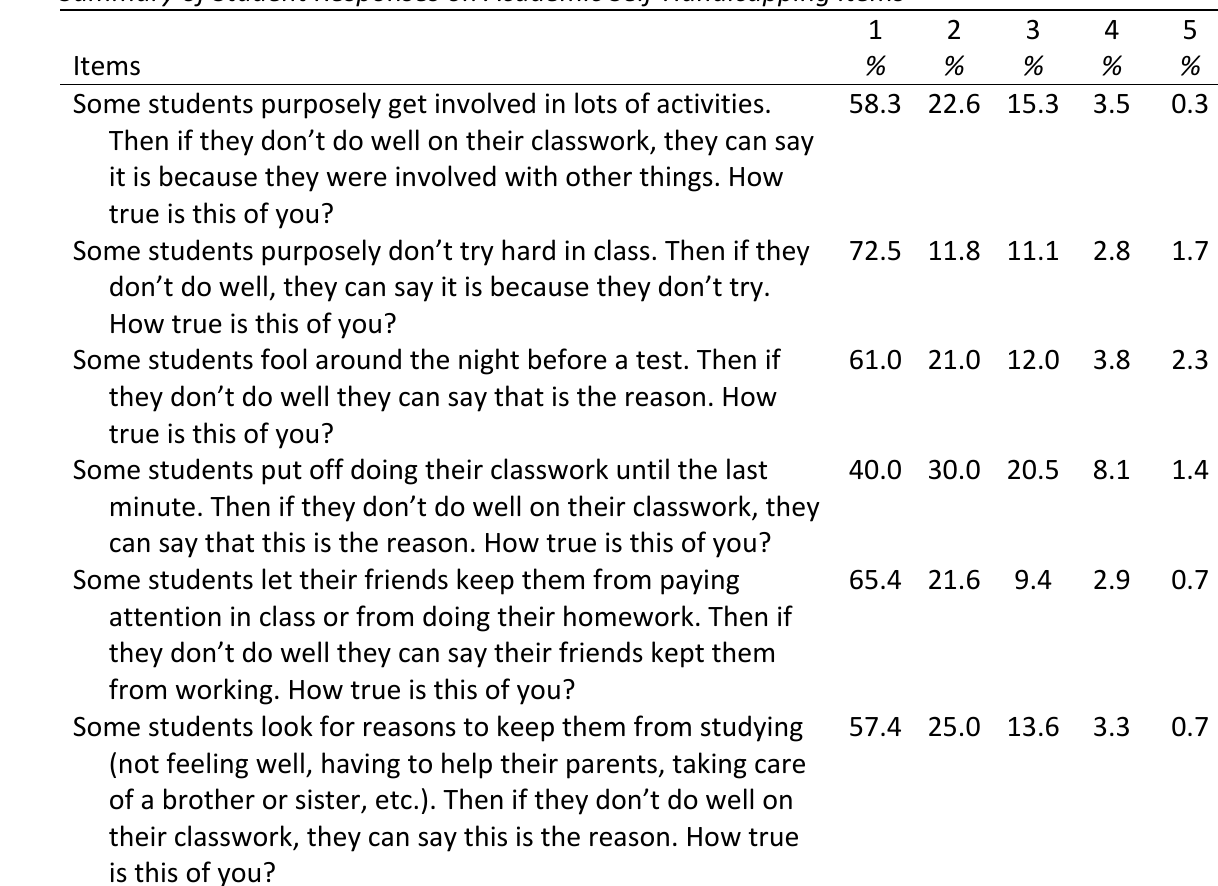
Summary of Student Responses on Academic Self-Handicapping